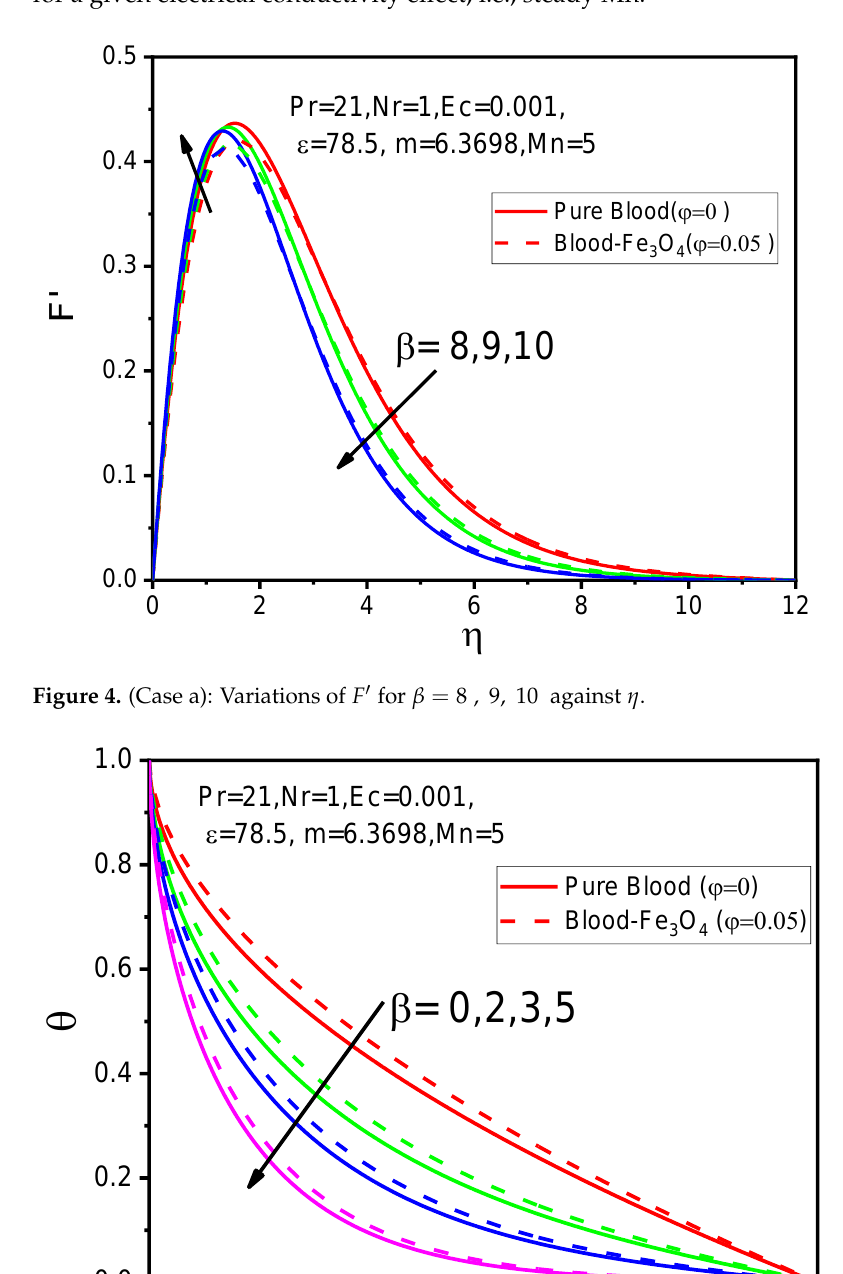
 . Figure 5. (Case a): Variations of θ for β = 0 , 2, 3, 5 against η